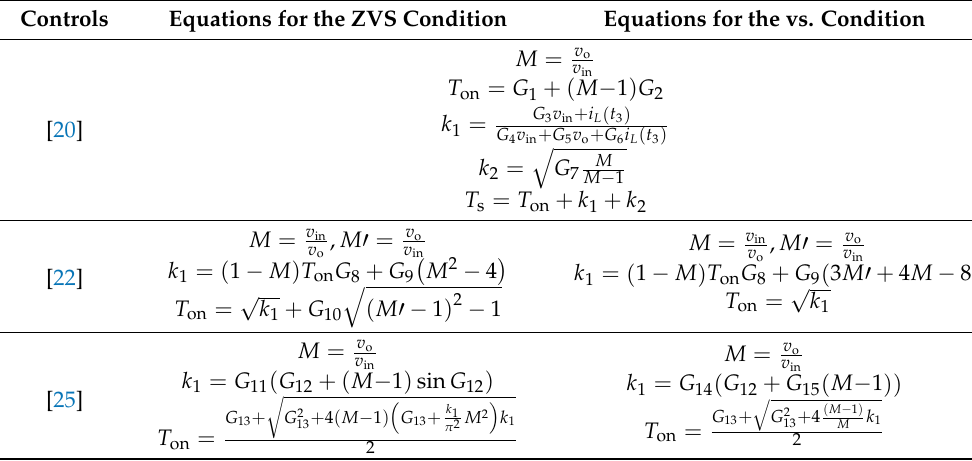
Table A1. The key equations required for mentioned referenced